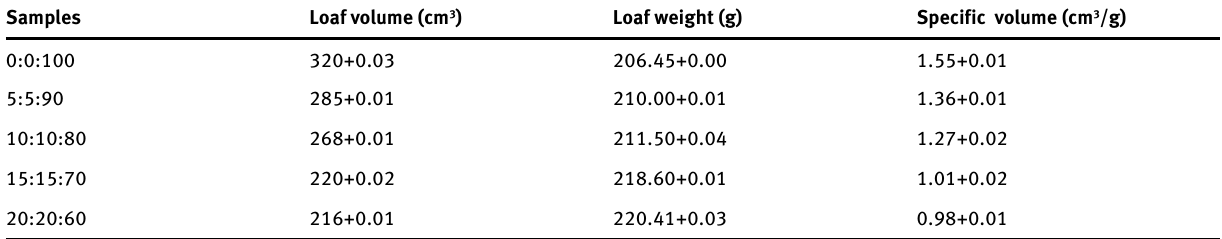
Table 3: Physical properties of the bread samples Samples Loaf volume (cm 3